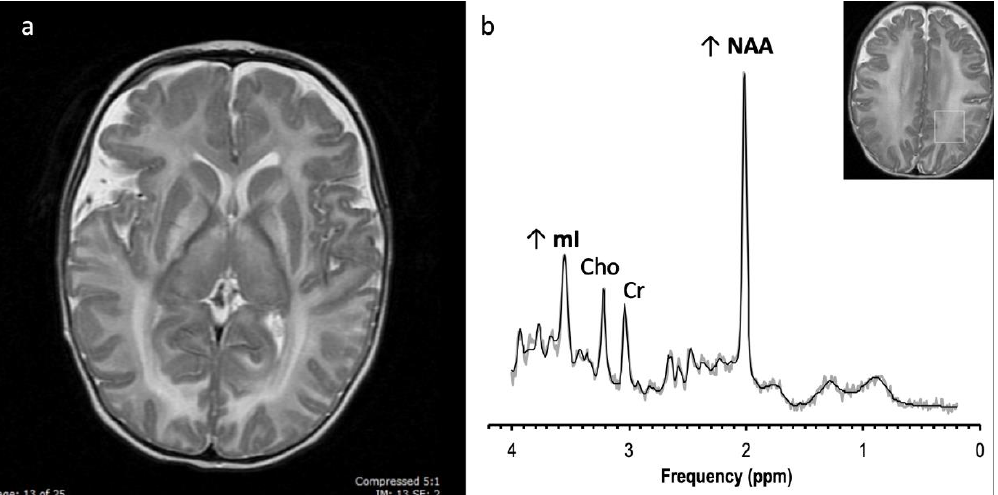
Figure 14. Canavan disease in a 4-month-old infant who presented with hypotonia, spasticity, and elevated urine organic acids. ( a ) Axial T2WI reveals diffuse white matter hyperintensity involving the subcortical U fibers throughout, the globi pallidi, and thalami with sparing of the striatum. ( b ) SV-MRS of the left parietal white matter shows severely elevated NAA (210 – 240% above normal) due to lack of enzyme degradation. MI is also elevated, and Cho and Cr are low.